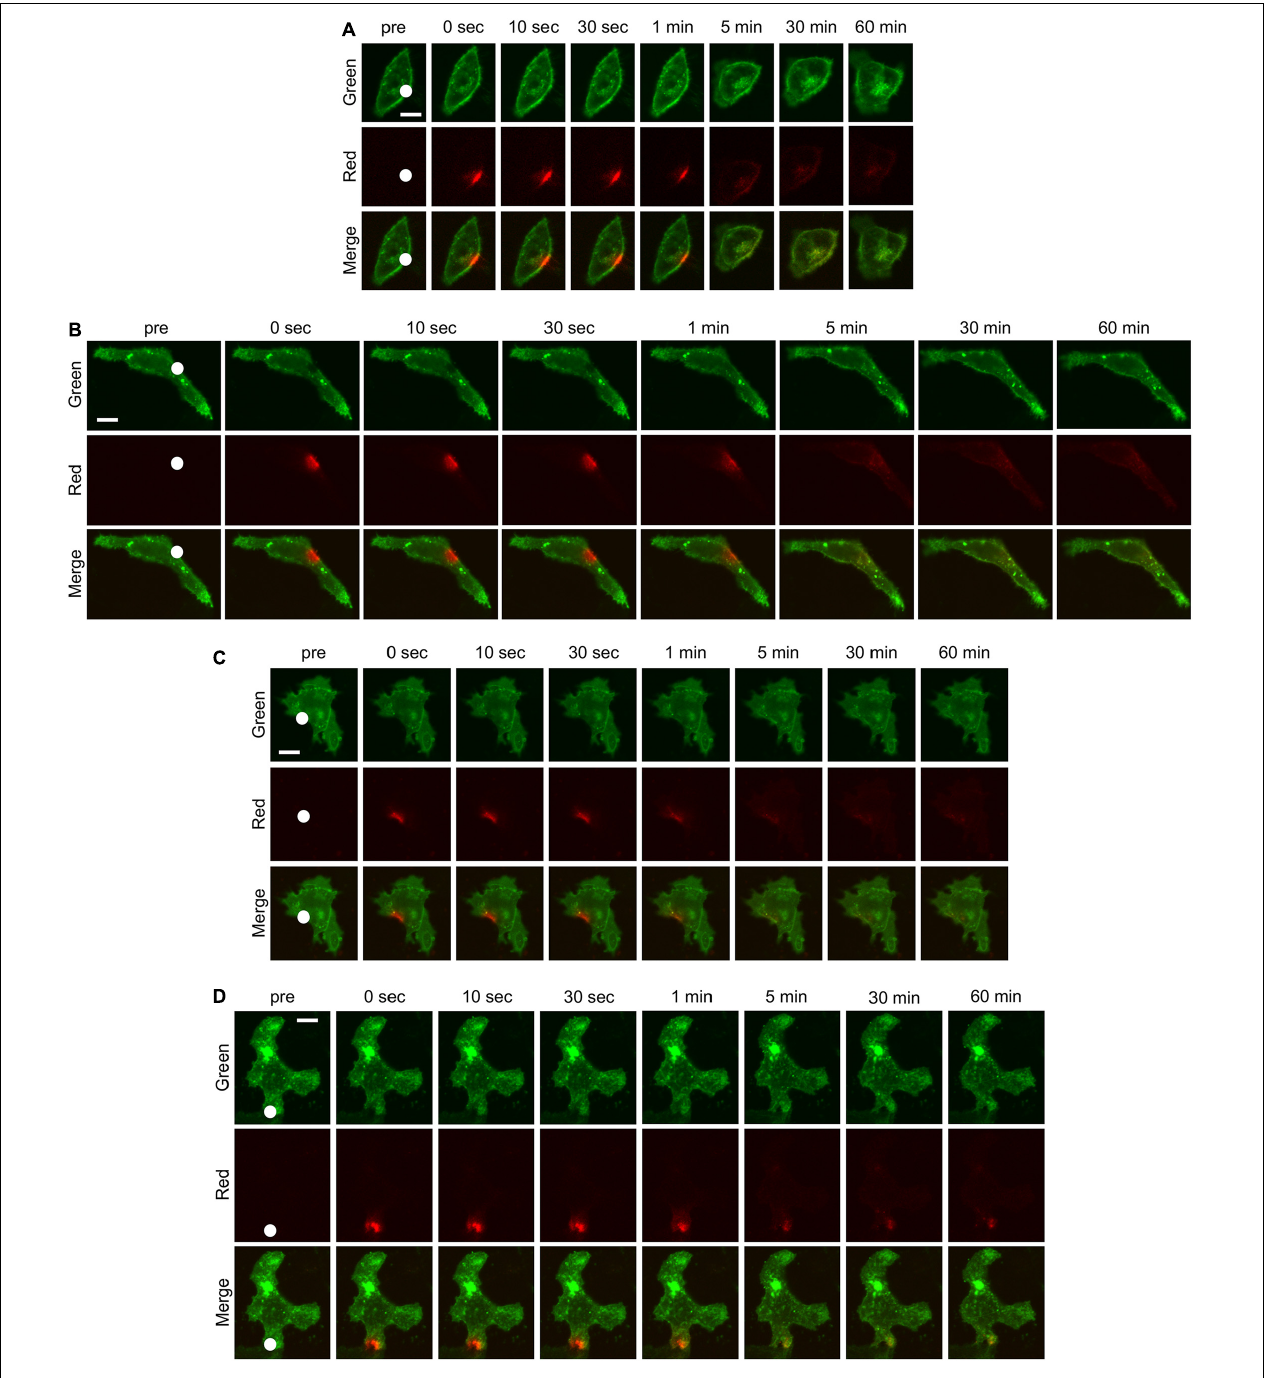
FIGURE 2 | Time-lapse confocal microscopic images of HeLa cells transfected with K IR 2.1-Dendra2 before and after photoconversion. The cells without any treatment (A) and the cells treated with Dyngo-4a (B) , Nocodazole (C) , Cytochalasin B (D) were imaged. The green fluorescence shows the localization of K IR 2.1 channel before photoconversion and the red fluorescence shows the localization of K IR 2.1 channel after photoconversion. White circle in each figure indicates the region where a blue laser was irradiated for photoconversion of Dendra2. Scale bar in each images indicate 10 µ m.